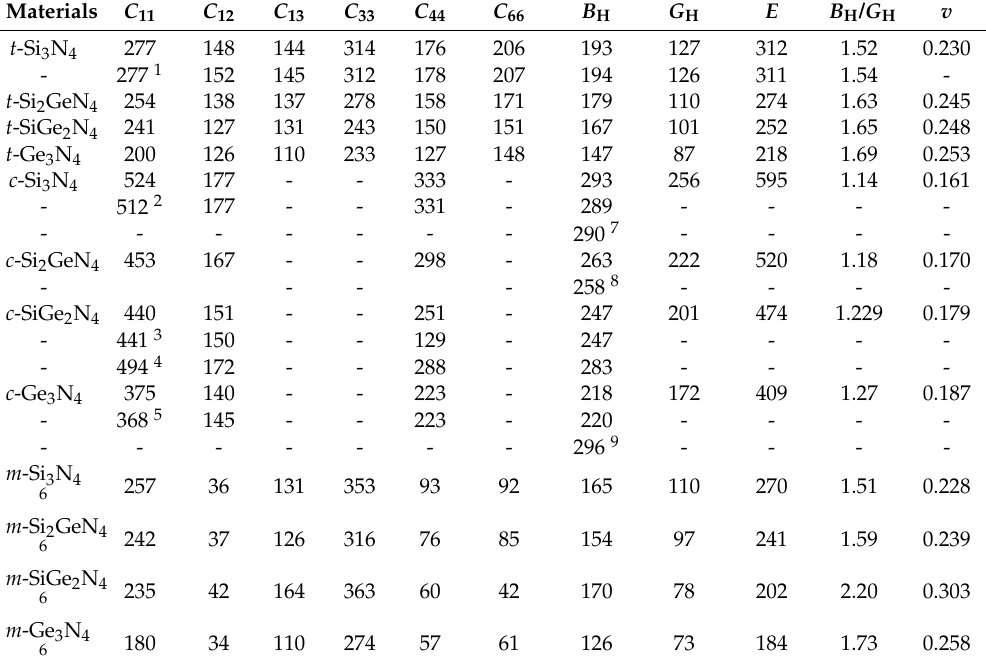
Table 2. Calculated elastic constants C ij (in GPa), bulk modulus B H , shear modulus G H , and Young’s modulus E (in GPa), the ratio of B H / G H and Poisson’s ratio v of t -Si x Ge 3 − x N 4 , c -Si x Ge 3 − x N 4 , and